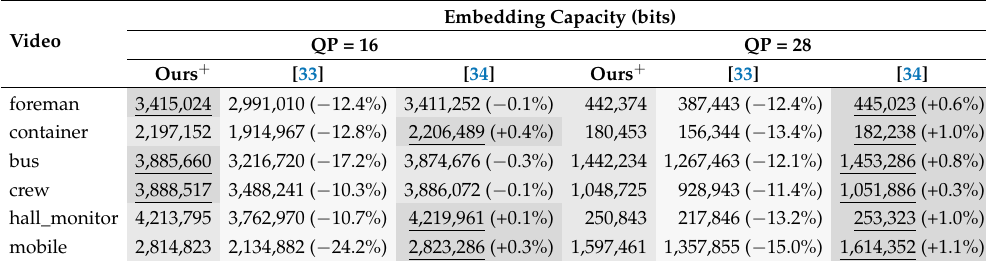
Table 2. The embedding capacity of the schemes using the ( 0,0 ) coefficient pairs, where the percentage figures in parentheses indicate the relative difference between other schemes and Ours +